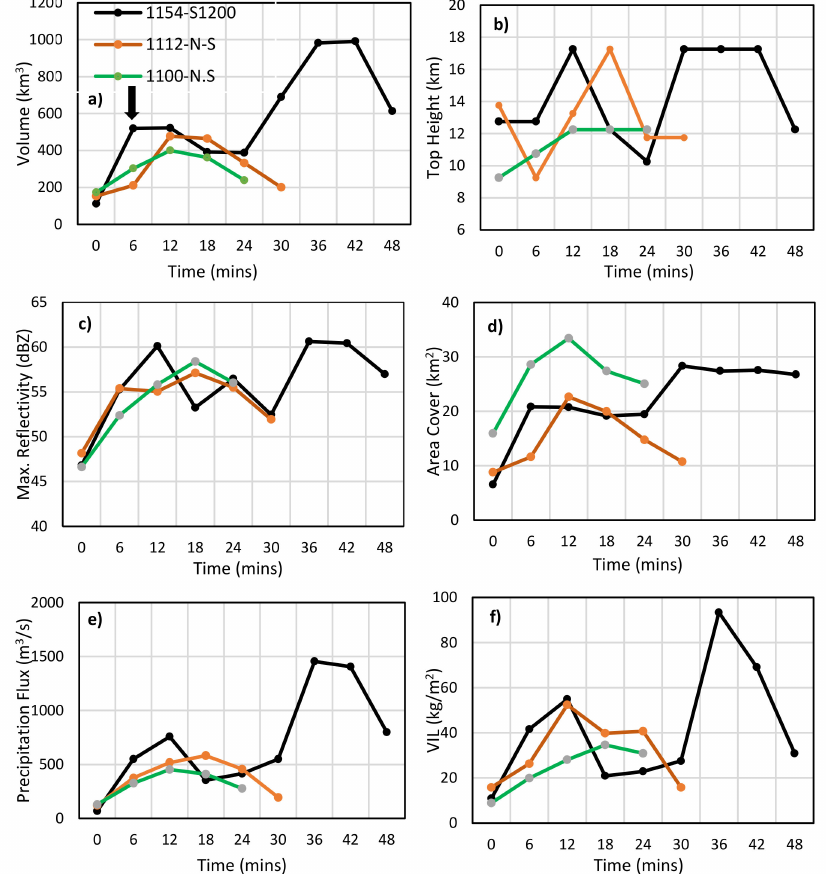
Figure 7. Temporal evolutions of ( a ) echo volume ( b ) echo top height, ( c ) maximum reflectivity ( d ) echo area cover ( e ) precipitation flux and ( f ) vertically integrated liquid water derived from the radar network for 14 August 2019 storms as a function of time (mins). The 1154_S1200 (black) curve denotes a storm first detected at 11:54 UTC and seeded at 12:00 UTC, while the 1112_N (orange) and 1100_N (green) curves denote storms first detected at 11:12 UTC and 11:00 UTC, respectively, and not seeded. The arrow in panel ( a ) depicts the onset of